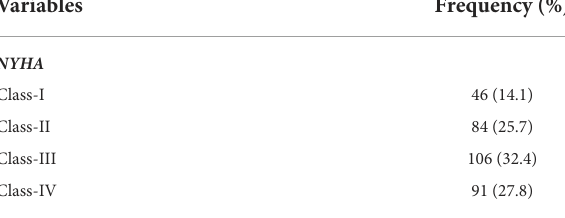
TABLE 4 New York Heart Association functional classification (NYHA).